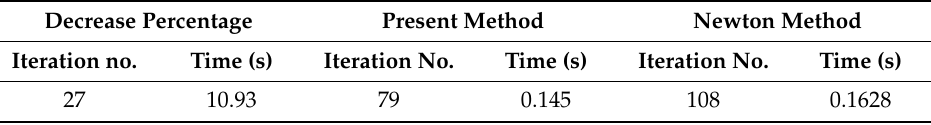
Figure 4. Space truss with 42 – members, all dimensions are in mm [28] . The load-displacement behavior of this model is shown in Figure 5. Table 2 shows the comparison of the classic Newton – Raphson with the perturbation method. It is concluded that the PM method is able to precisely evaluate the results, and reduce the computational cost and iteration number by 12.89% and 29.1%, respectively.